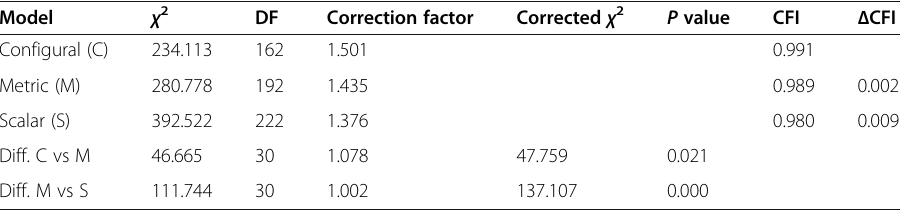
Table 9 Tests of cross-country measurement invariance — alternative protein source. Model